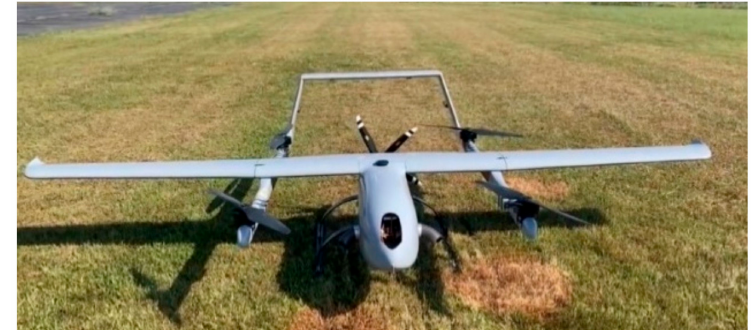
Figure 1. Test vehicle a modified Mugin 3600 VTOL unmanned aircraft.